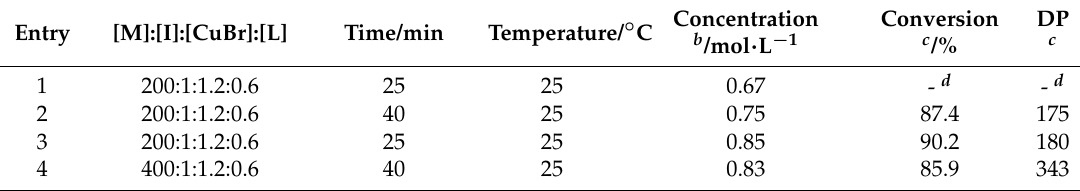
Table 2. Experimental data of Cu 0 -mediated LRP of SBMA copolymer a .